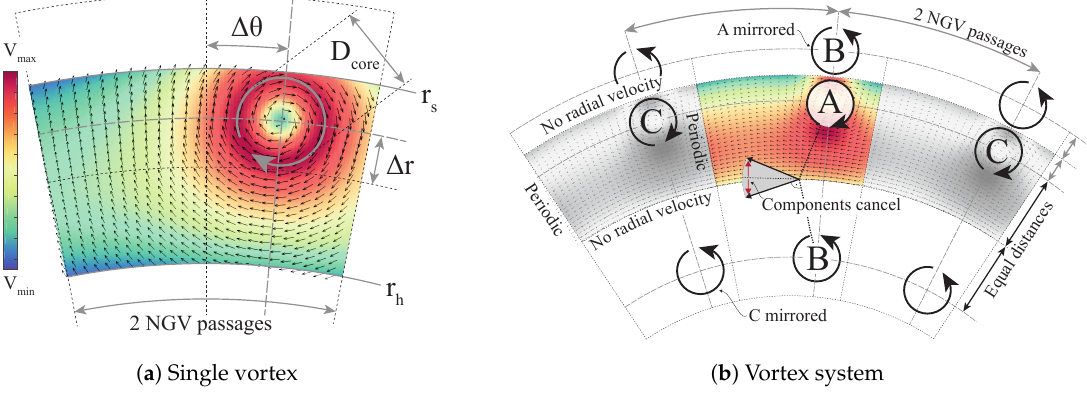
Figure 3. Swirler vortex modelling: ( a ) A single Lamb-Oseen vortex with vectors penetrating the end walls and non-periodic sector boundaries and ( b ) a system of vortices with periodic sector boundaries and no radial velocity component at the end walls. NGV: nozzle guide